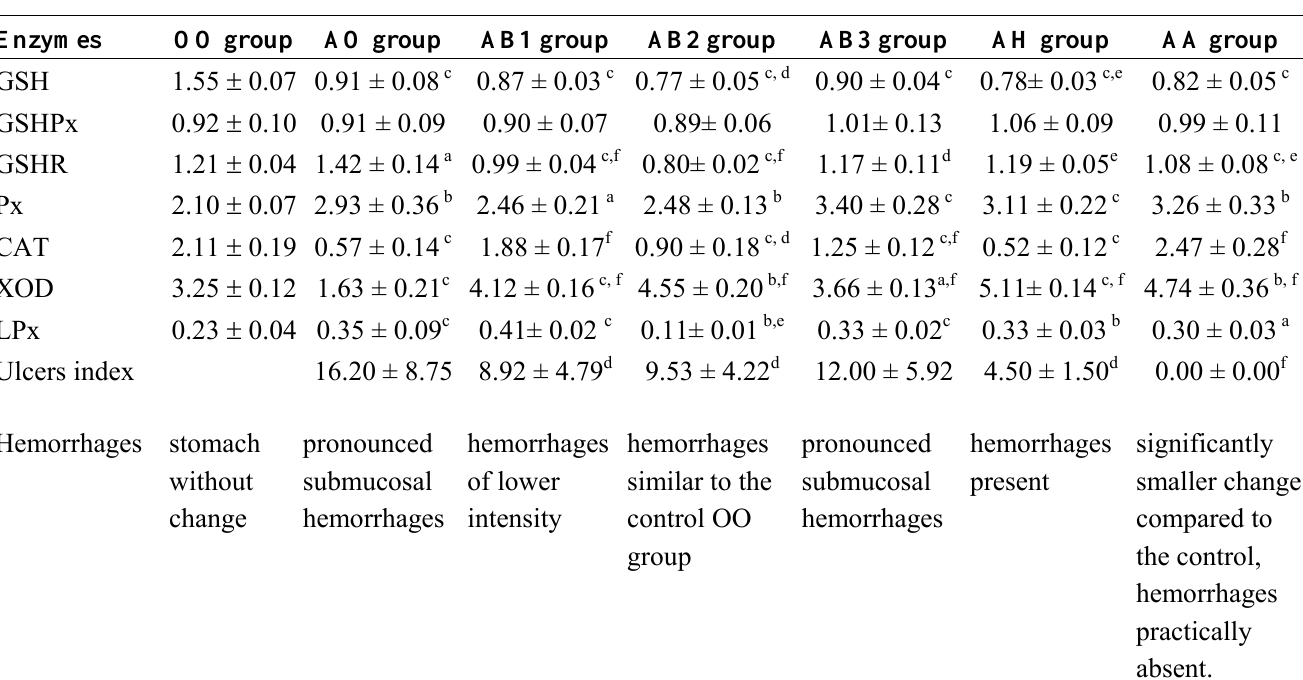
Table 1. Investigated biochemical